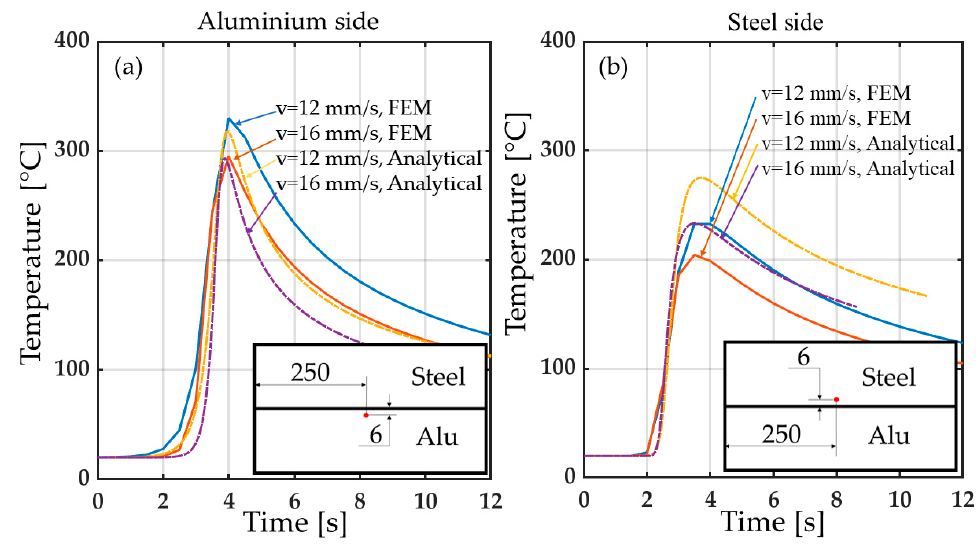
Figure 11. Temperature–time plots exported from two points at the same distance from the weld